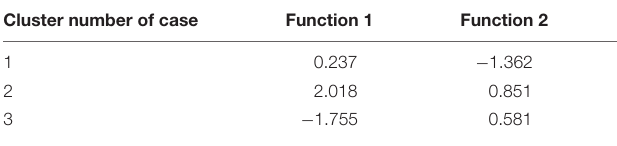
students evidencing high levels of motivation and